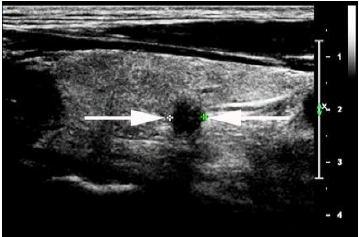
Figure 3. A 36-year-old man with PTMC with a taller-than-wide shape in the right thyroid lobe with suspicious thyroid capsule involvement sign (PTMC involving the posterior thyroid capsule, arrows; + indicated measurement of the PTMC). The patient underwent right central neck lymph node dissection, and the surgical–histopathologic results showed the presence of one central neck lymph node metastases. PTMC: papillary thyroid microcarcinoma.